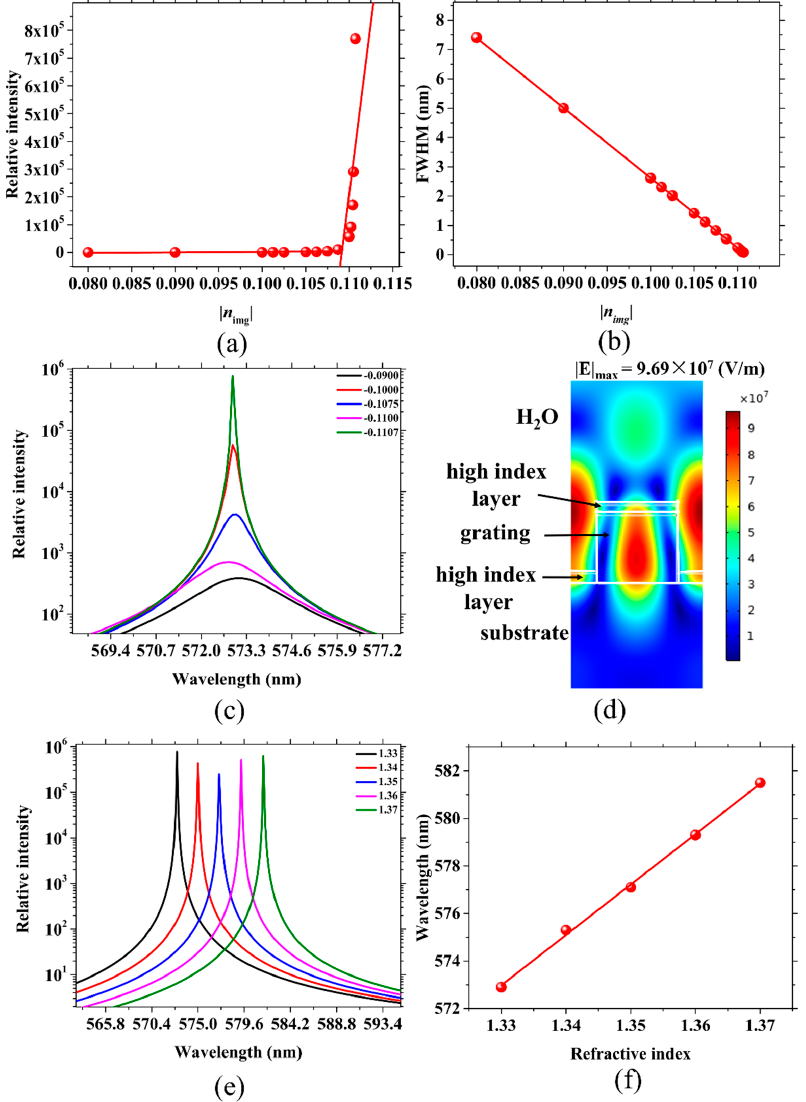
Figure 3. ( a ) The relationship between the relative intensity and the the absolute value of the active grating gain values ( | n img | ). ( b ) Corresponding FWHMs for various | n img | . ( c ) The variation trend of the resonant peak patterns reflected by five different values of n img . ( d ) Electric field distribution for a resonant wavelength of 572.9 nm with n c = 1.33. ( e ) An example of the resonant wavelength shift corresponding to the change in n c . ( f ) The linear fitting between λ peak and n c in ( e ) with d g = 200 nm, d wg = 0 nm, DC = 60% and Λ = 400 nm .